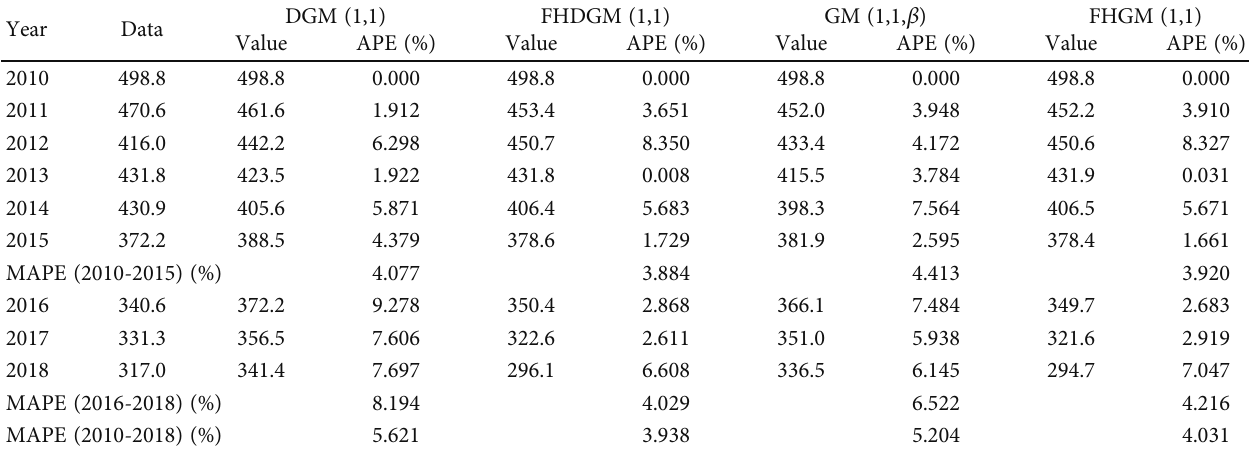
Table 2: Fitted and predicted values in coal consumption of the United States.